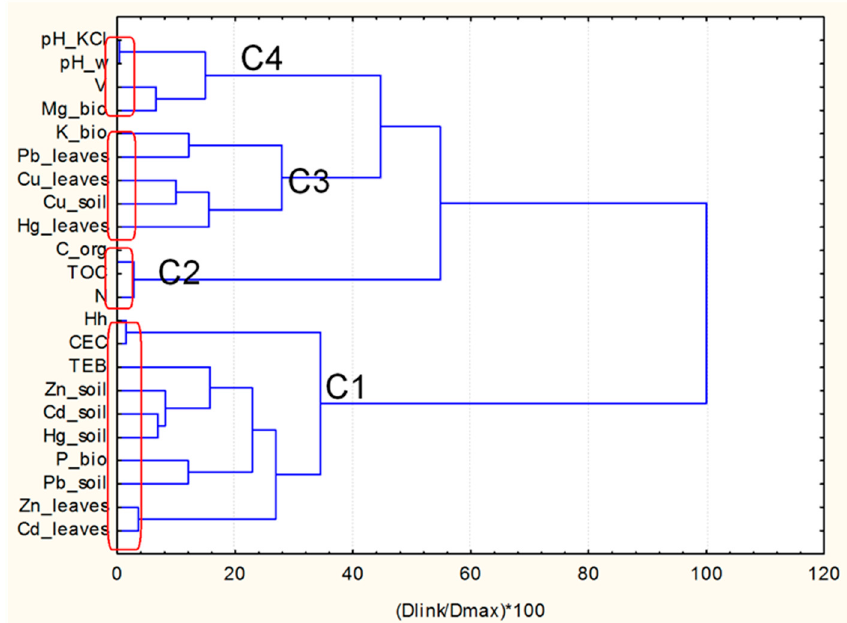
Figure 2. Hierarchical dendrogram for four clusters of variables. The conditional name of the clusters are (bottom to up): C1—structural and soil pollution factor; C2—organic factor; C3—cabbage leaves Pb, Cu, Hg accumulation factor; C4—soil acidity factor.